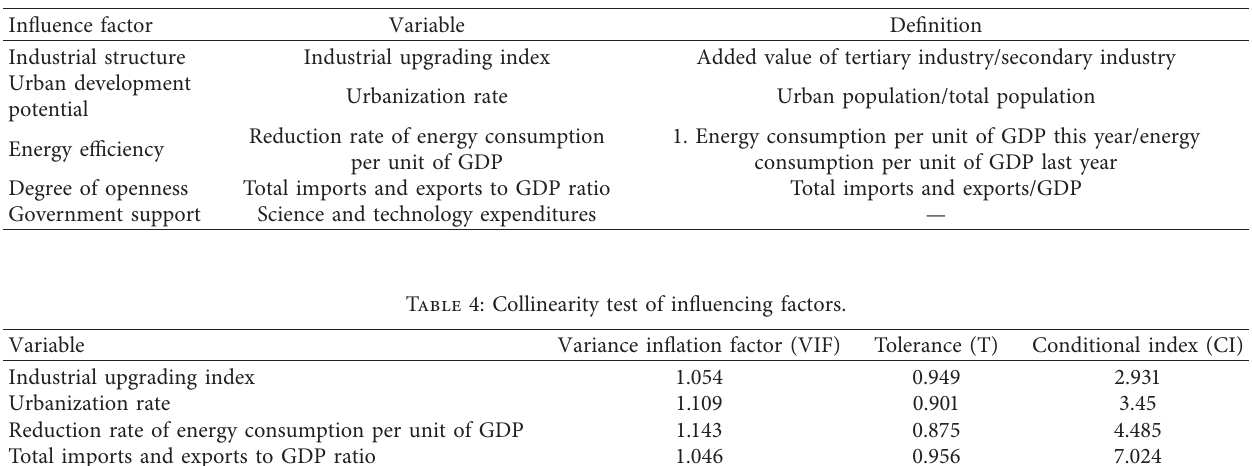
Table 3: Influencing factors of IGD.